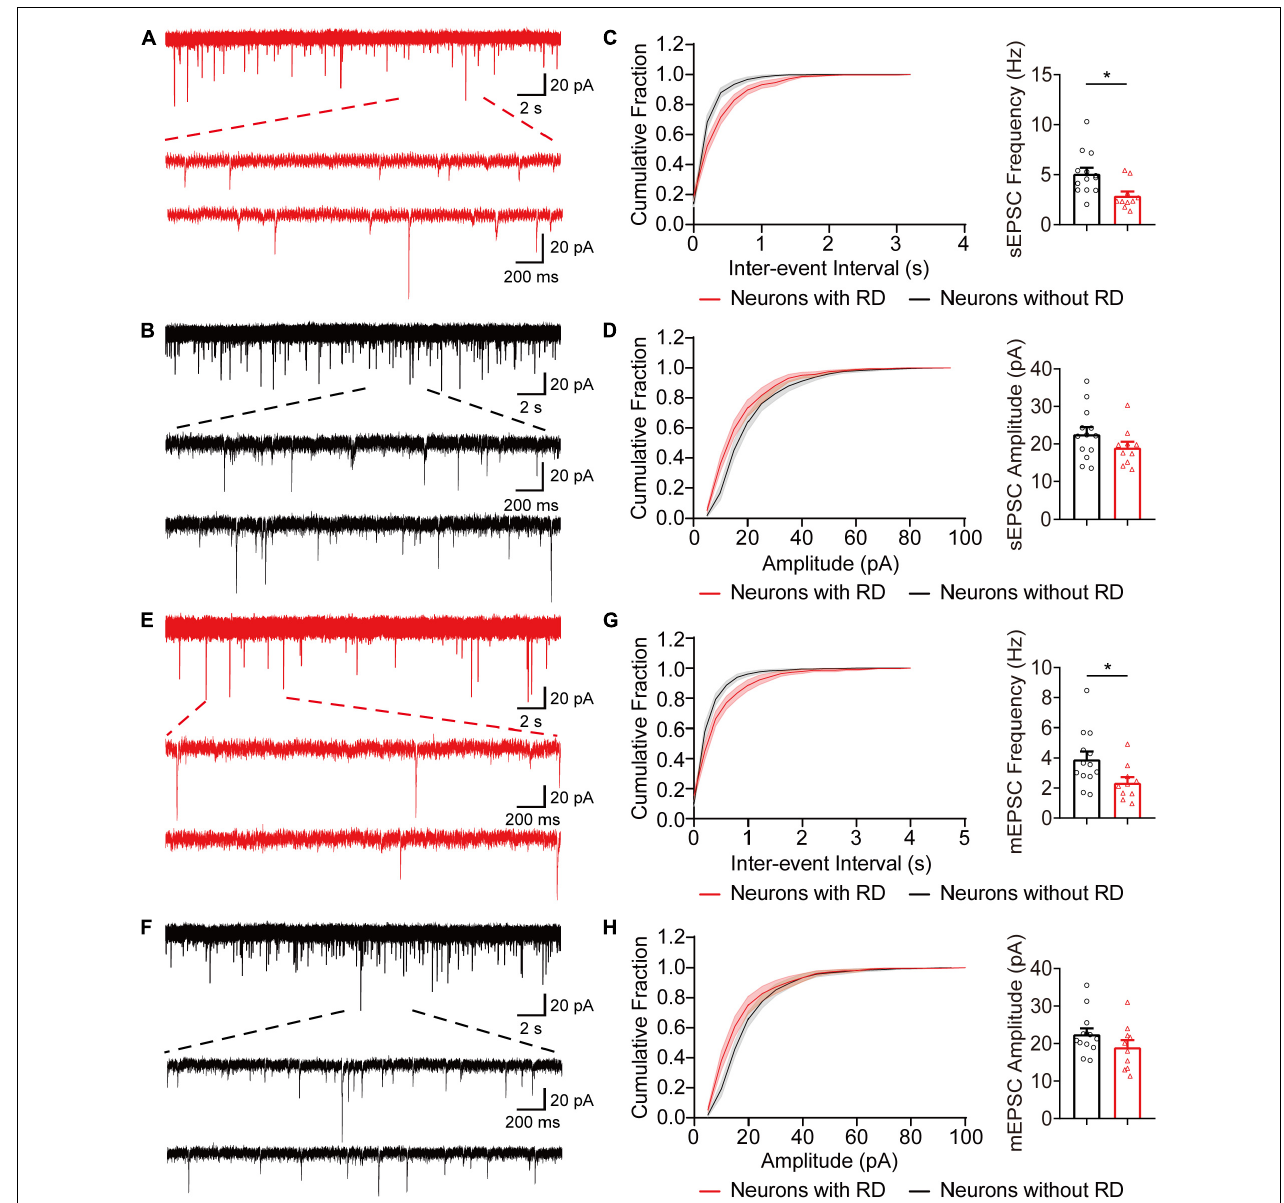
FIGURE 4 | Excitatory synaptic inputs differ in SG neurons with or without RD. (A,B) Exemplar traces of sEPSCs in SG neurons expressing (A) or lacking (B) RD. The bottom panels show the proportional enlargements corresponding to the upper traces. (C,D) Cumulative probability and summary bar graphs of the inter-event interval (C) as well as the amplitude (D) showing a lower frequency of sEPSCs in neurons with RD. (E,F) Typical traces of mEPSCs in RD-expressing (E) or RD-lacking (F) SG neurons. (G,H) Summarized data showing that RD-expressing neurons had a lower mEPSCs frequency compared to those lacking RD (G) , while mean amplitudes of mEPSCs from the two populations were comparable (H) . sEPSC, spontaneous excitatory postsynaptic current; mEPSC, miniature excitatory postsynaptic current. * p <